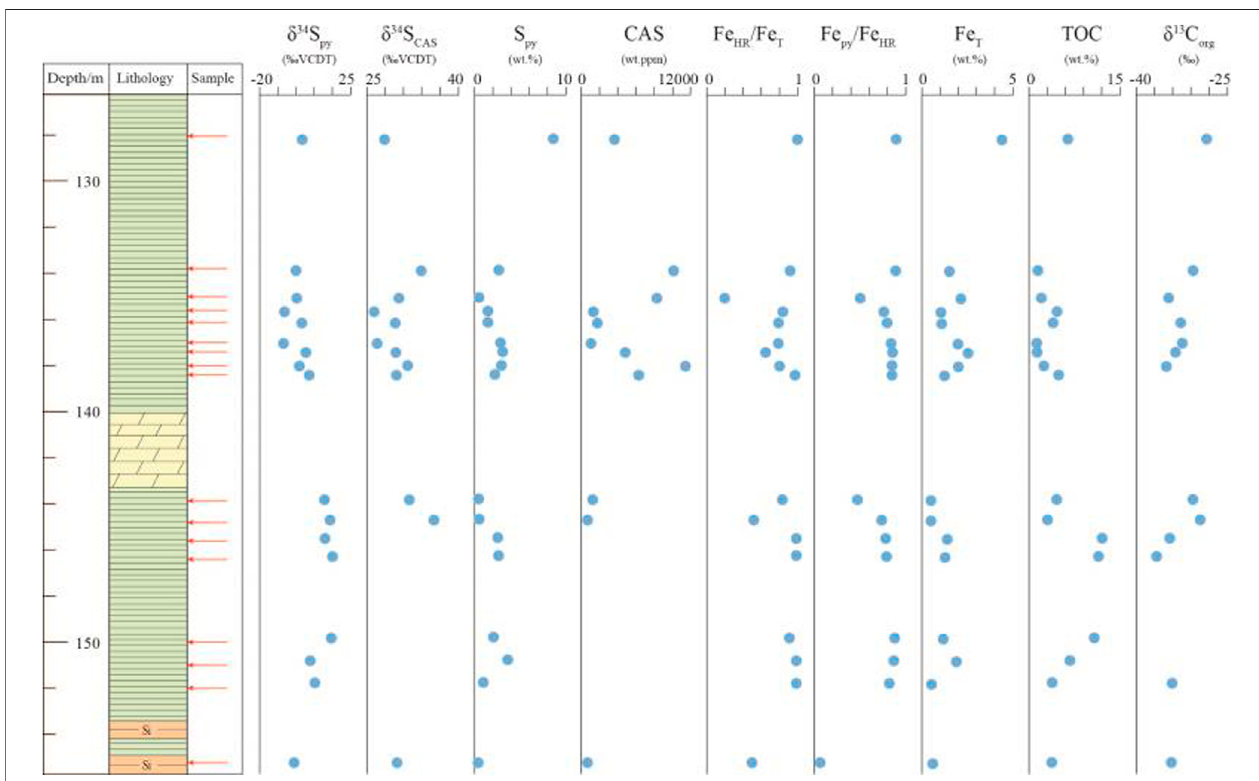
FIGURE 2 | Geochemical pro fi les of the early Cambrian Yurtus Formation in the Tarim Block, northwestern China. Fe speciation data have been reported in Zhu et al. (2021).